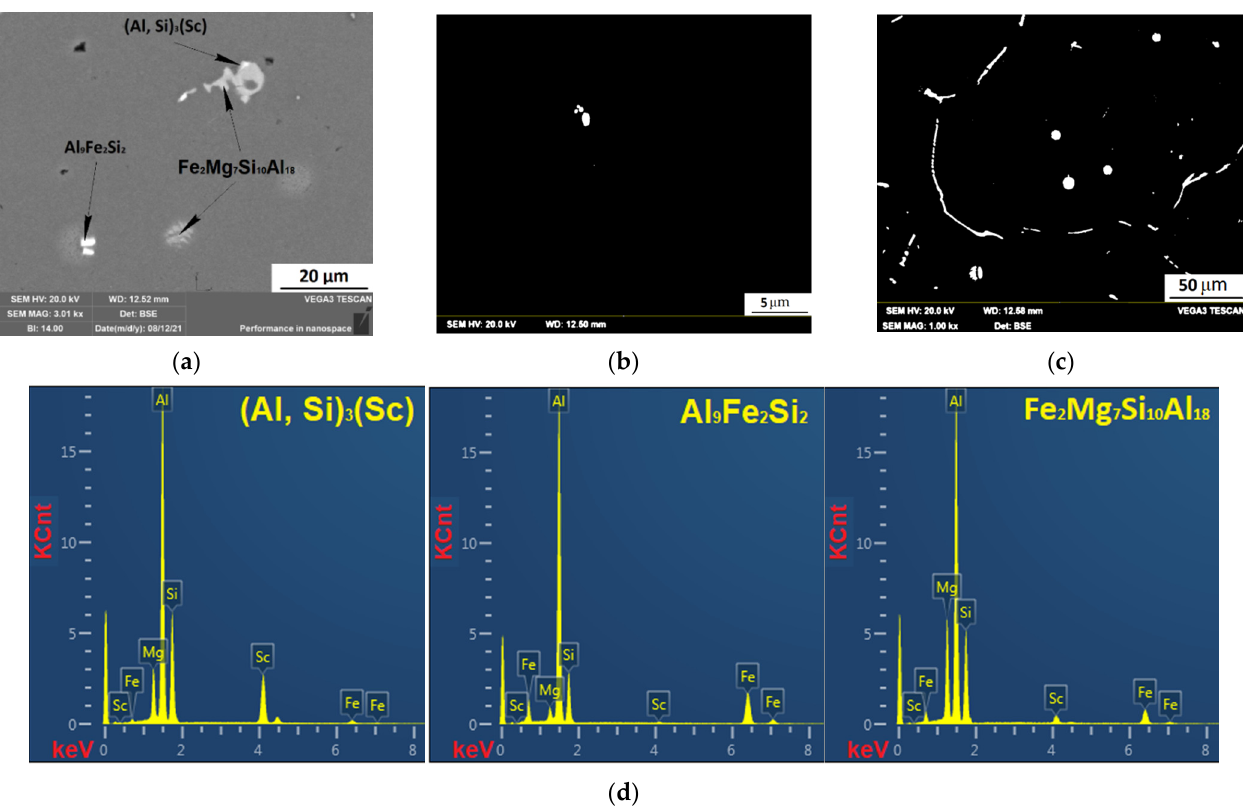
Figure 8. Al 0.5 Mg 1.3 Si 0.3 Sc main types of intermetallic compounds ( a ); small dispersoids ( b ); large particles ( c ); result of the EDS investigation of chemical composition of the intermetallic compounds ( d ).